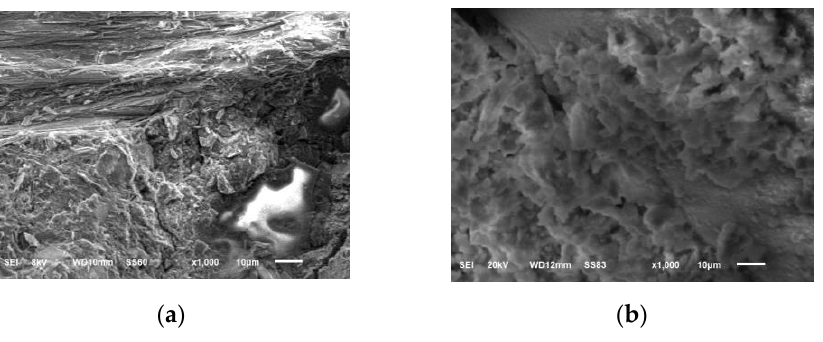
Figure 4. Contact layer “cement stone—aggregate” through a microscope: ( a ) composition C1-II; ( b ) composition C2-II.